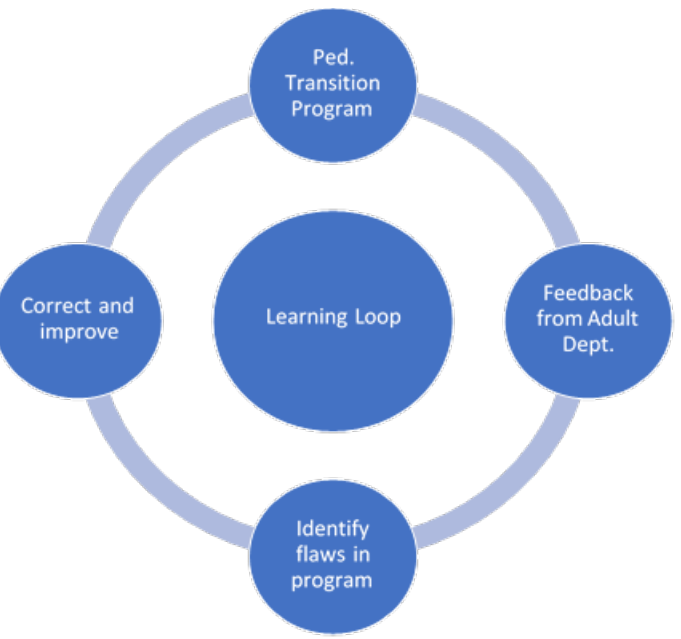
Figure 1. Learning loop inspired by Hansen (2018) [22]. Adapted with permission from the author Hansen, M.T whom holding the copyright, published by Simon & Schuster 2018).